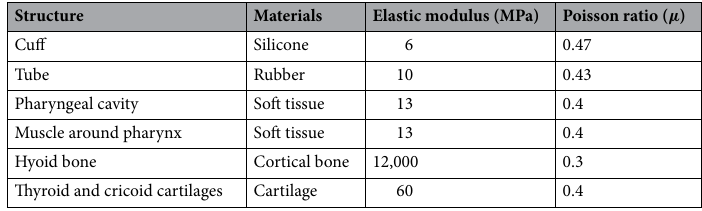
Table 1. Element type and material parameters.